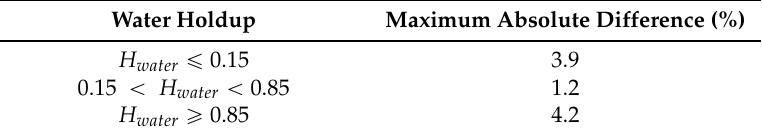
Table 3. Maximum absolute difference between C N , fem and C N , approx